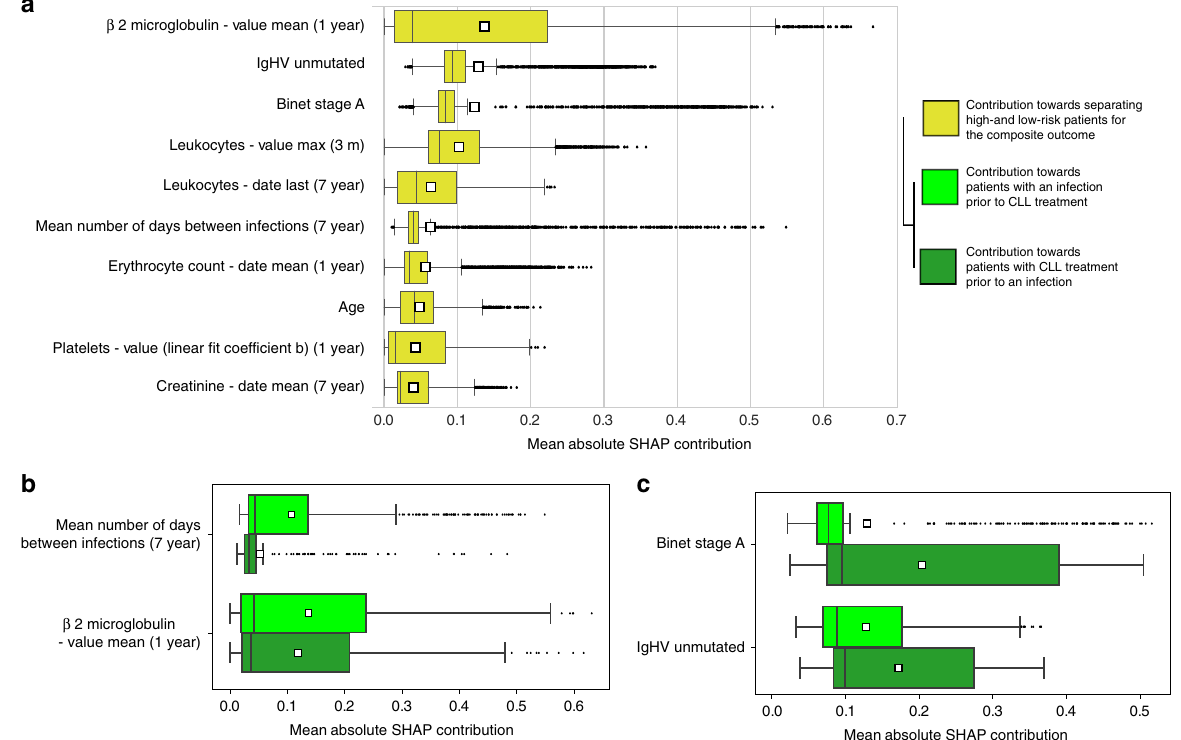
Fig. 7 Risk factors for composite outcome, infection and treatment. a Top 10 risk factors for the composite outcome. b Top 2 risk factors speci fi c to infection prior to CLL treatment. c Top 2 risk factors speci fi c to CLL treatment prior to infection. Mean absolute SHAP contribution indicates the magnitude by which the probabilistic output of CLL-TIM is affected by the given feature. This was calculated using 3720 Danish CLL patients (i.e. training, validation and test cohorts) and averaged over CLL-TIM ’ s 28 base-learners. Speci fi city to infection in b was calculated as the mean difference between the feature ’ s SHAP values for patients who as a fi rst event, had an infection, to those that had CLL treatment. The converse of this was used to calculate speci fi city to CLL treatment in c . Mean differences for b , c were signi fi cant ( p < 0.005) using one-tailed Mann – Whitney U-Test. Risk factors identi fi ed in a-c were also con fi rmed using multiple univariate tests (Supplementary Data 2, 3). For box-and-whisker plots, whiskers are the 95% con fi dence interval, white square is the mean, centre line is the median, bounds of box are the interquartile range and black dots are outliers. When patients had missing data for a given feature the SHAP contribution was